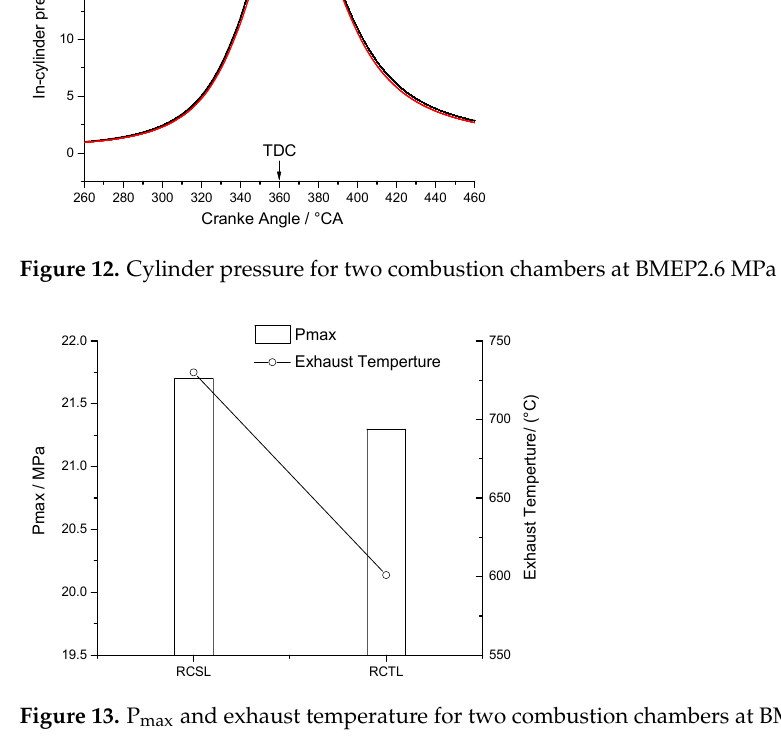
Figure 13. P max and exhaust temperature for two combustion chambers at BMEP2.6 MPa load.